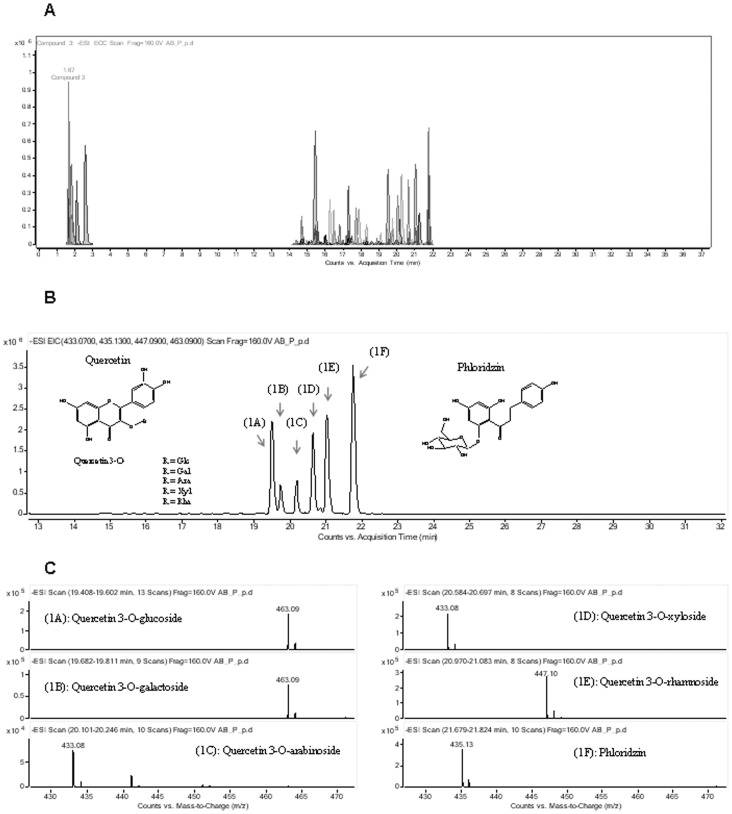
Separation and identification of polyphenolic compounds in DAPP crude AB powder.Extracted ion chromatograms of some identified polyphenolic compounds in AB powder using accurate mass measurement; (A). Extracted ion chromatograms of quercetin glycosides and dihydrochalcone (B) and their related mass spectra (C): quercetin 3-O-glucoside, m/z 463.0905 (1A); quercetin 3-O-galactoside, m/z 463.09018 (1B); quercetin 3-O-arabinoside, m/z 433.07914 (1C); quercetin 3-O-xyloside, m/z 447.07977 (1D); quercetin 3-O- rhamnoside, m/z 447.09506 (1E); and phloridzin, m/z 435.13171 (1F) obtained with negative ion electrospray ionisation. These polyphenols are provided from a mixture of 250 µg of crude extract DAPP in 1 mL Optima grade water.